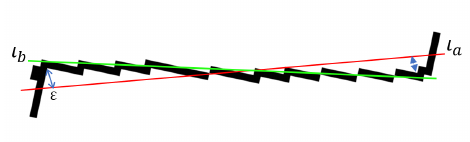
Figure 3. Rotational line fitting error introduced by corner edge pixels that fall within error threshold ε defined for the line ι a . The desired line is ι b .